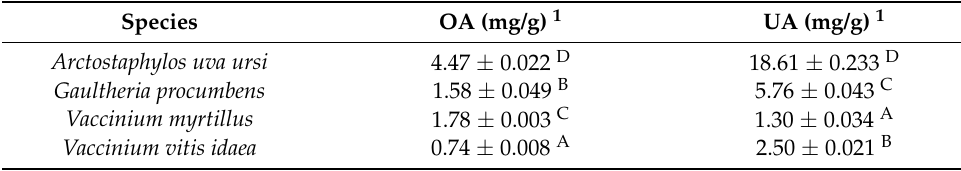
Table 7. Content of OA and UA in investigated leaf